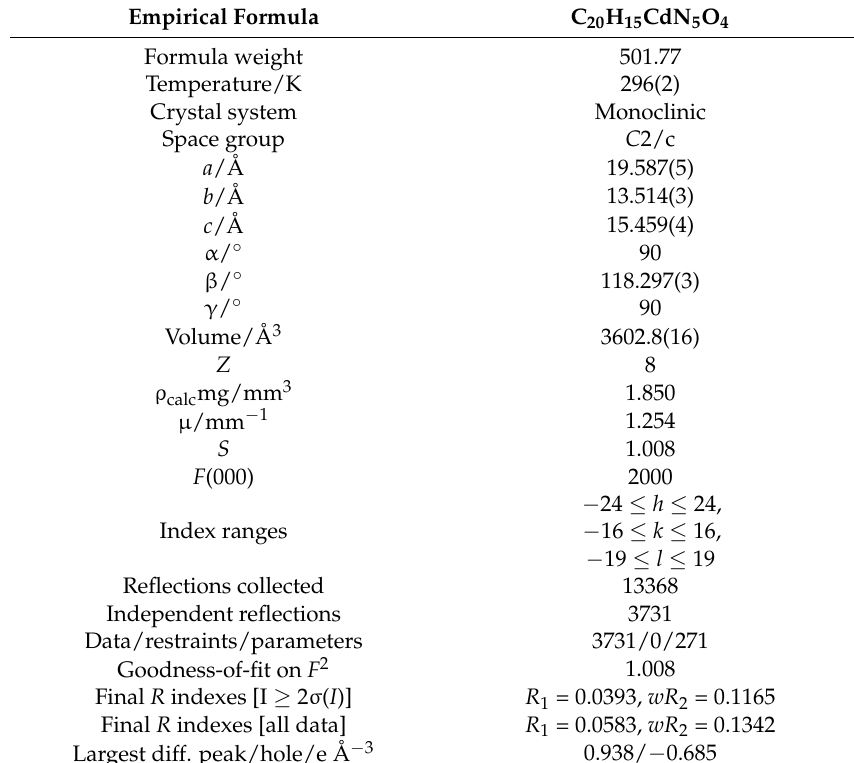
Table 1. Crystallographic data and structure refinement for 1